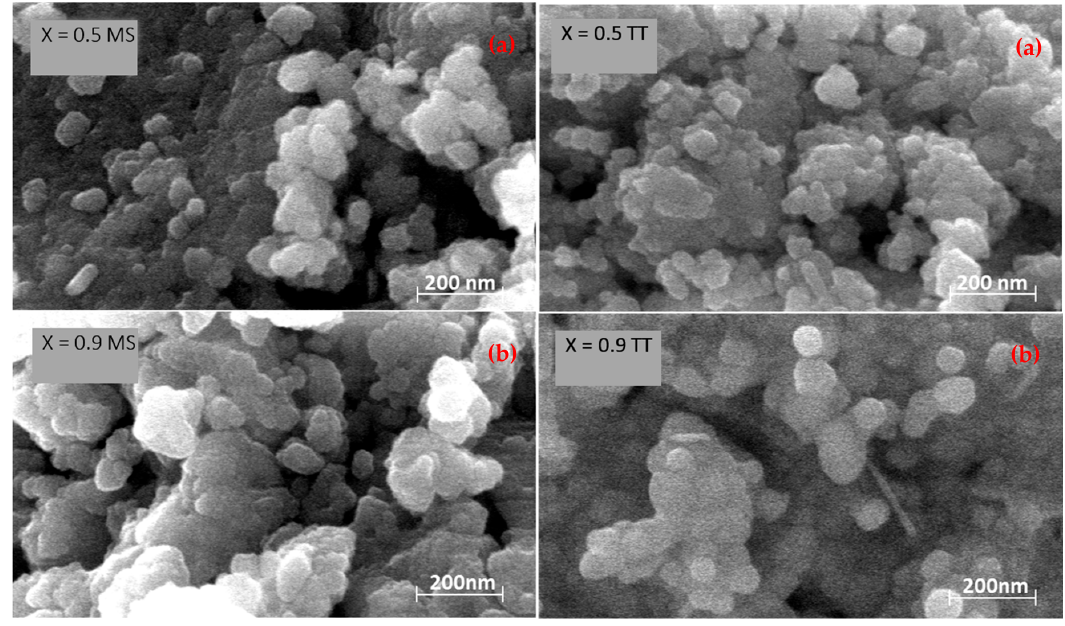
Figure 2. Scanning electron micrographs of powders mechanosynthesized (MS), and thermally treated (TT) at the maximum temperature before decomposition for ( a ) Y 0.5 Bi 0.5 Mn 0.5 Fe 0.5 O 3 and ( b ) Y 0.1 Bi 0.9 Mn 0.1 Fe 0.9 O 3 .